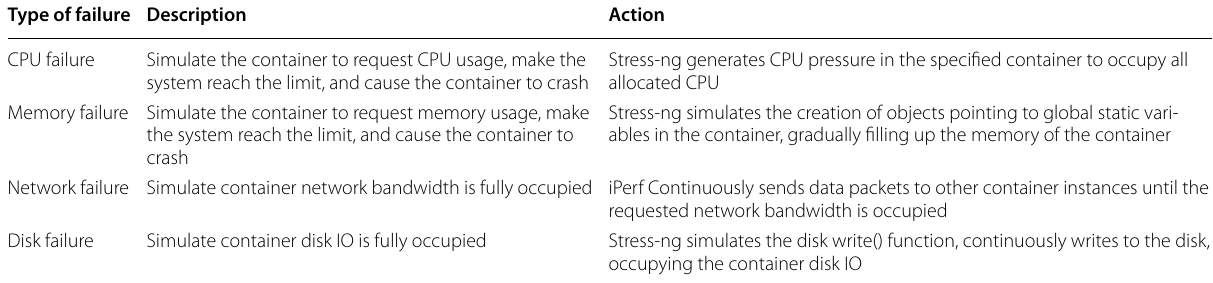
Table 3 Types and methods of fault injection Type of failure Description Action